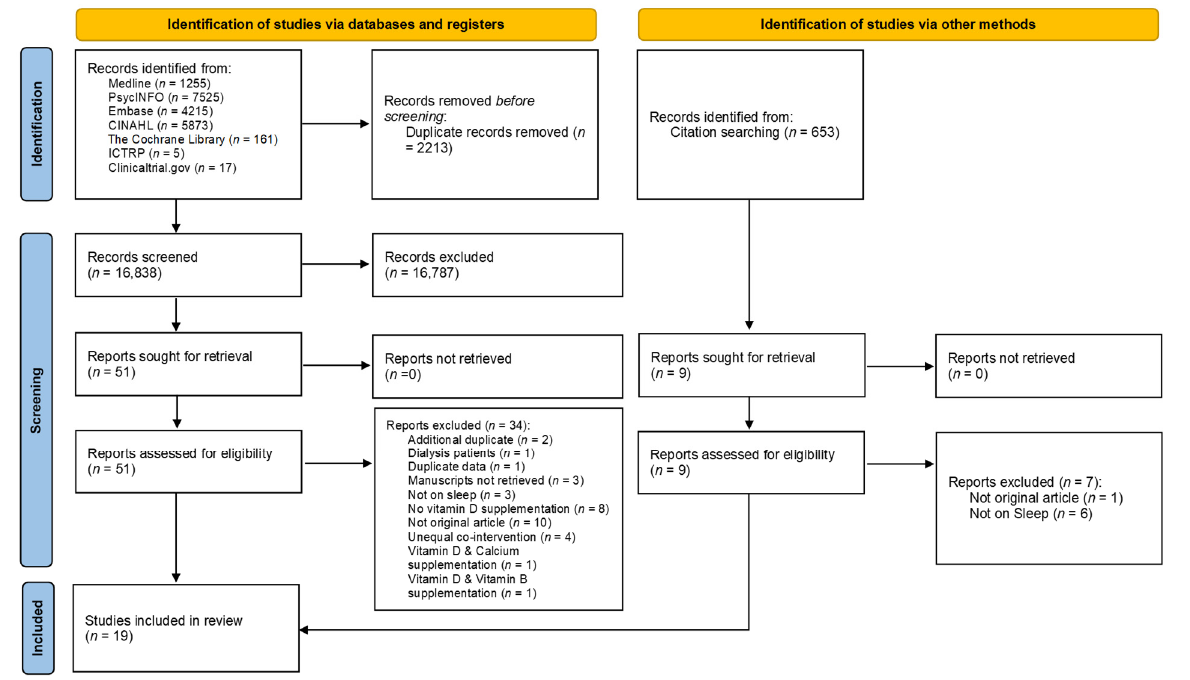
Figure 1. Preferred Reporting Items for Systematic Reviews and Meta-Analyses (PRISMA) diagram of study selection. ICTRP: International Clinical Trials Registry Platform.